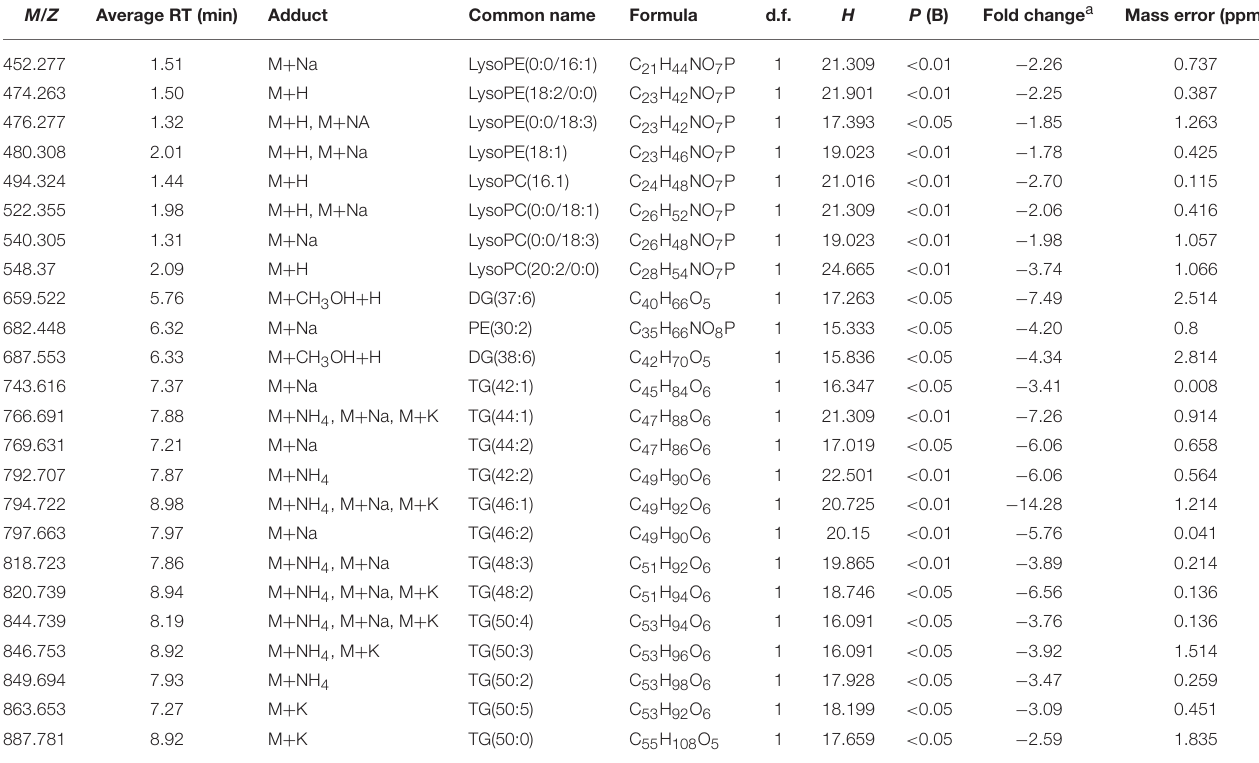
TABLE 2 | Non-polar biomarkers.